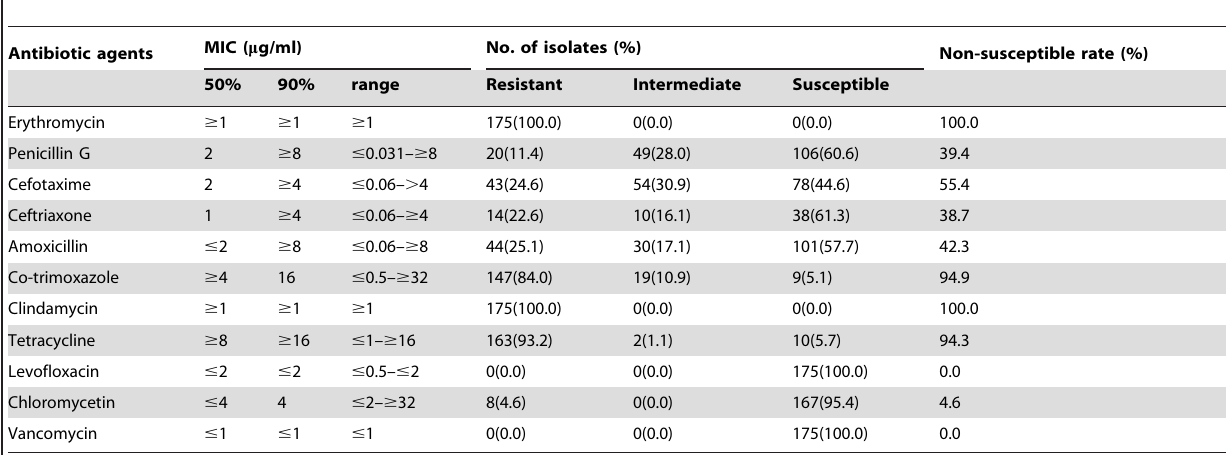
Table 2. Antimicrobial susceptibility and MICs of 175 S.pneumoniae strains isolated from respiratory infection Children younger than 5